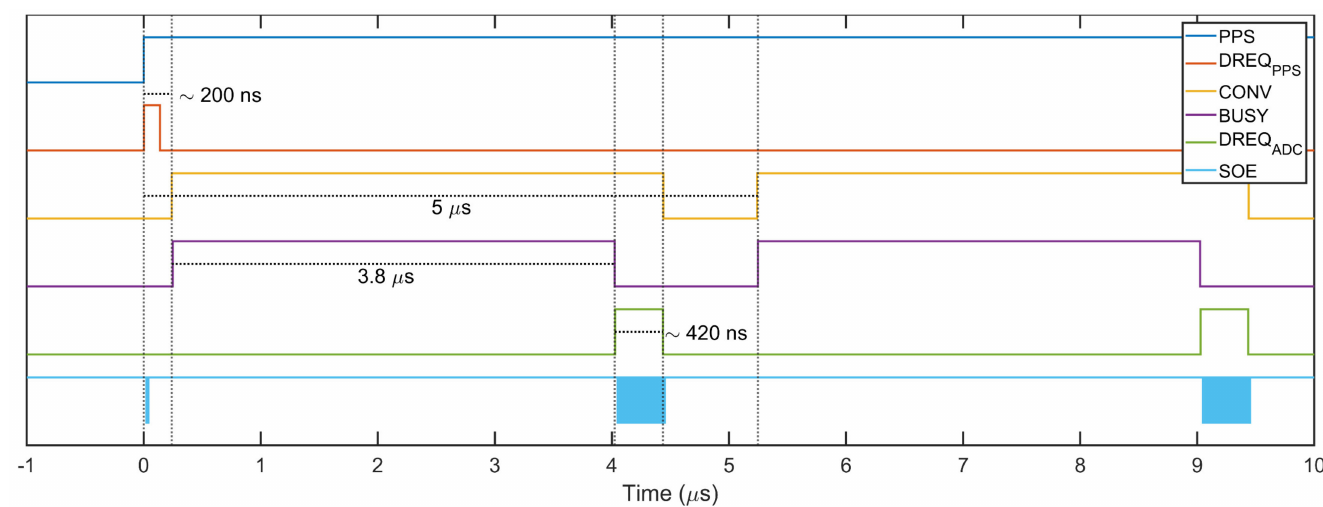
Figure 7. Timing sequence from logic analyzer for a sample rate of 200